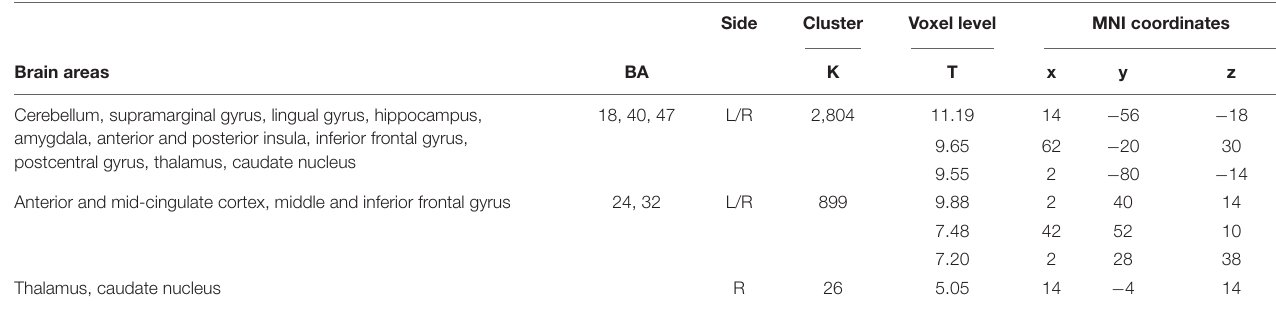
Side Cluster Voxel level MNI coordinates